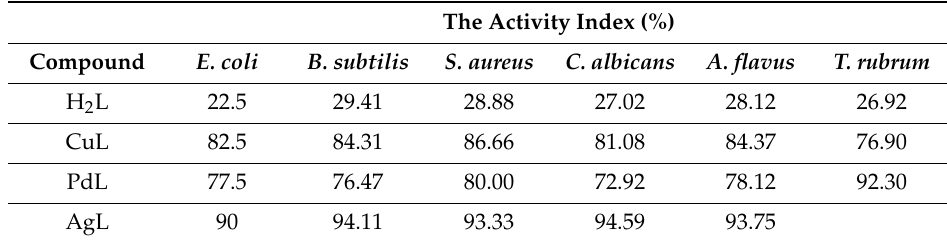
Table 8. The activity index of the new H 2 L ligand and its CuL, PdL and AgL complexes against selected strains of bacteria and